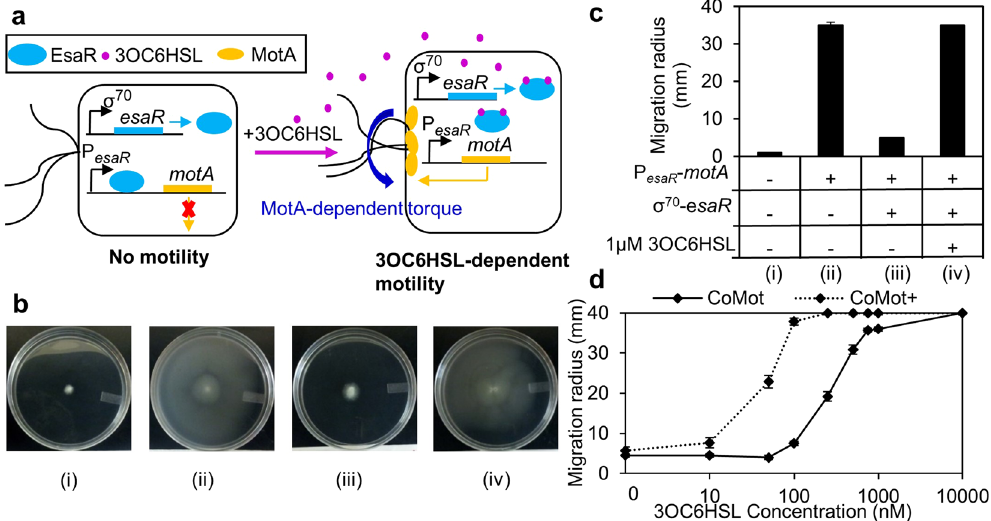
Figure 1. Engineered CoMot strains display 3OC6HSL-dependent motility: ( a ) Illustration of 3OC6HSL- dependent motA expression in the CoMot strain. Expression of motA is under the control of the P esaR promoter. esaR is constitutively expressed from a σ 70 -dependent promoter and represses P esaR . In the absence of 3OC6HSL, motA expression is repressed and the cell is non-motile. Following addition of 3OC6HSL, P esaR is de-repressed and motA is expressed. MotA generates the torque required to rotate the flagella and cellular motility is restored. ( b ) Plates were inoculated with (i) Δ motA , (ii) Δ motA transformed with plasmids containing P esaR - motA (iii) CoMot cells ( Δ motA transformed with plasmids containing P esaR - motA and P σ 70 - esaR ) on plates without 3OC6HSL and (iv) CoMot cells on plates with 1 μ M 3OC6HSL and incubated at 30 °C for 36 h. Representative plate images are shown. ( c ) Migration radius was measured as the distance between the inoculation point and the visible edge of migration of cells on the plate for cases (i–iv). Error bars represent one standard deviation from the mean migration radius of three biological replicates. ( d ) Plates with 3OC6HSL concentration ranging from 0 to 10 μ M were inoculated with CoMot or CoMot + ( Δ motA transformed with plasmids containing P esaR - motA and P σ 70 - esaR-D9 1 G ). The migration radius was measured after 36 h at 30 °C. Error bars represent one standard deviation from the mean migration radius of three biological